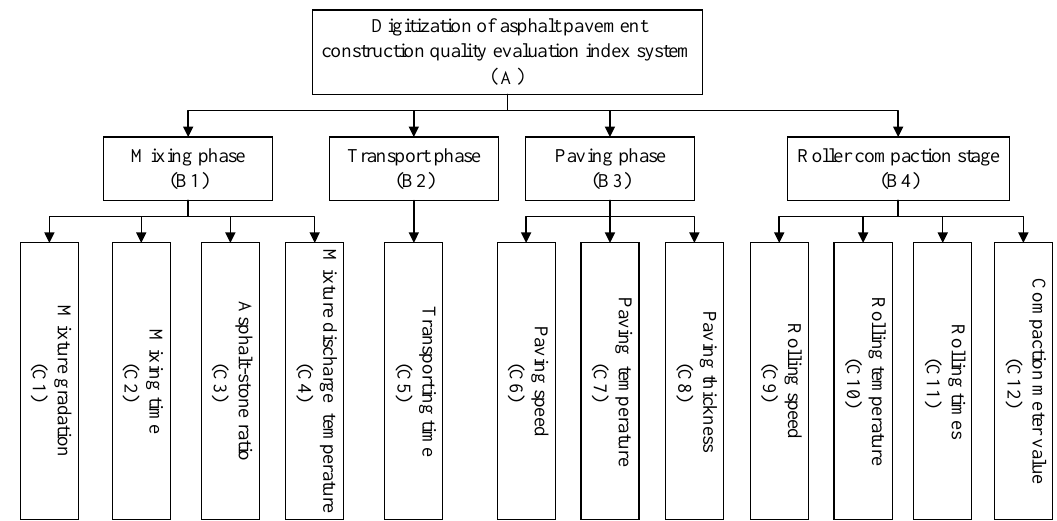
Figure 5. Digital construction quality evaluation index system of asphalt pavement.